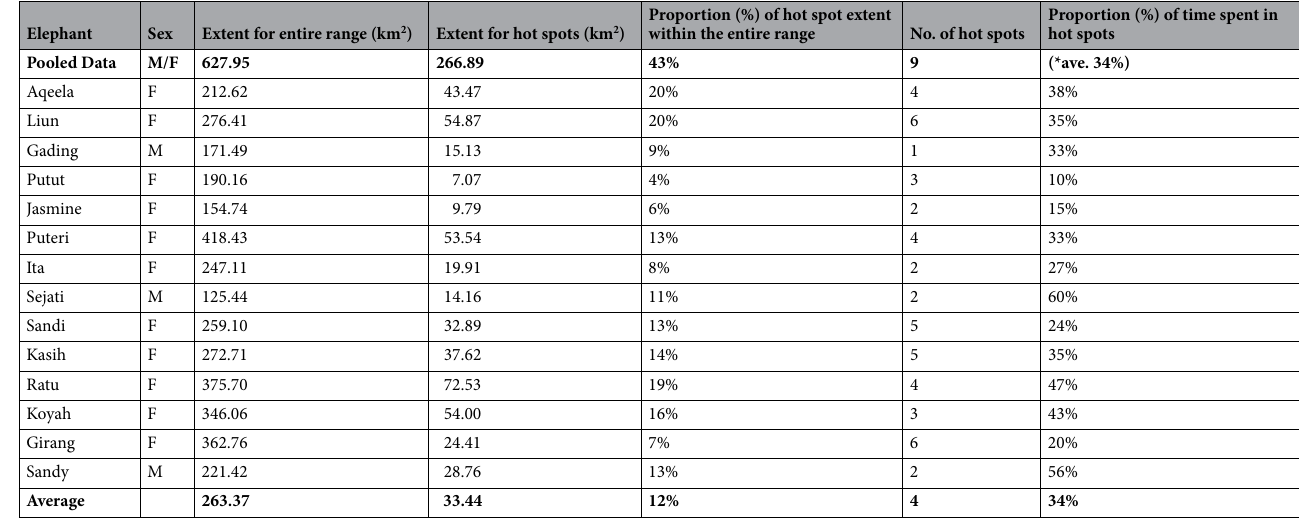
Table 3. Total extent for elephants entire range and hot spots (in km 2 ), the proportion (%) of the extent of